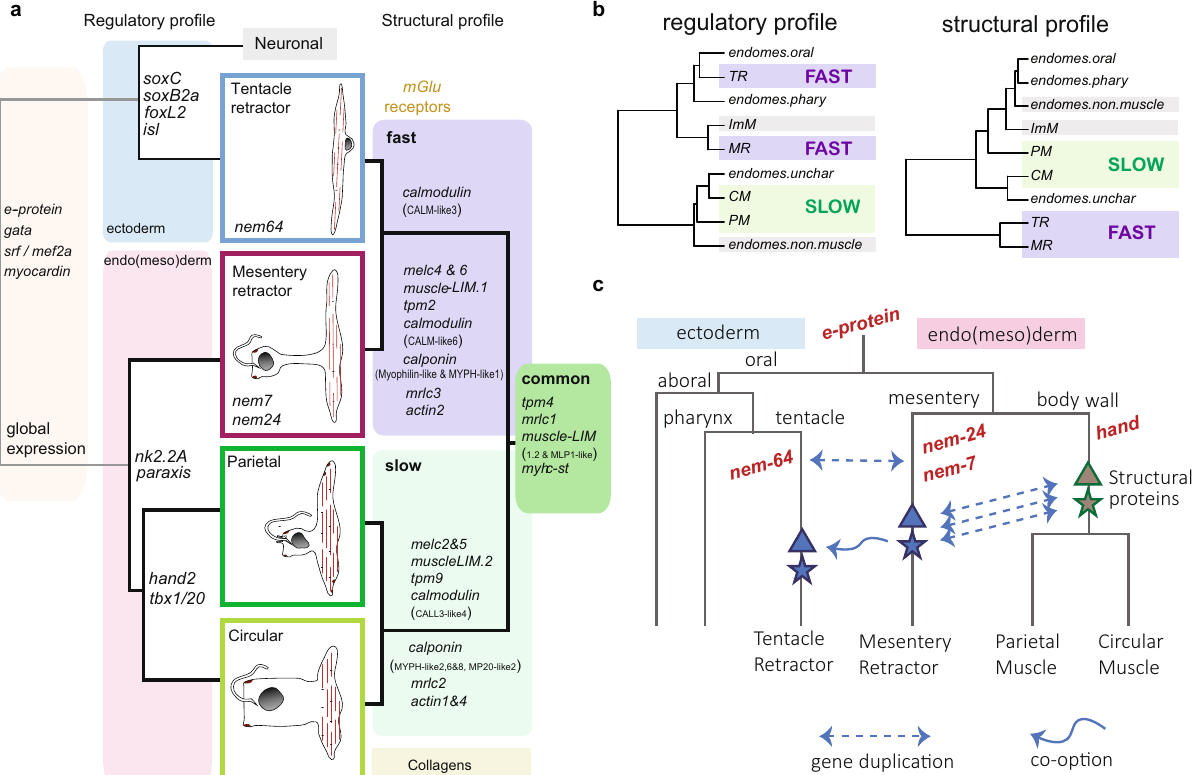
Fig.5|Summaryofanthozoanmuscletranscriptomeandmodelofmusclecell evolution. a The left side shows key regulatory genes and their association with the four muscle types shown in the center panel. The dendrogram on the left indicatesthedevelopmentalrelationshipsbetweenthecelltypes.Individualgenes within the cell type boxed in the center panel are proposed here as cell-type- speci fi c regulatory factors, whereas those positioned on the dendrogram are shared between descendants of these branches. On the right side, the described effector modules, or aponemes, are indicated. Note that the composition of this list is identical, but the individual paralogs are speci fi c to each effector module.